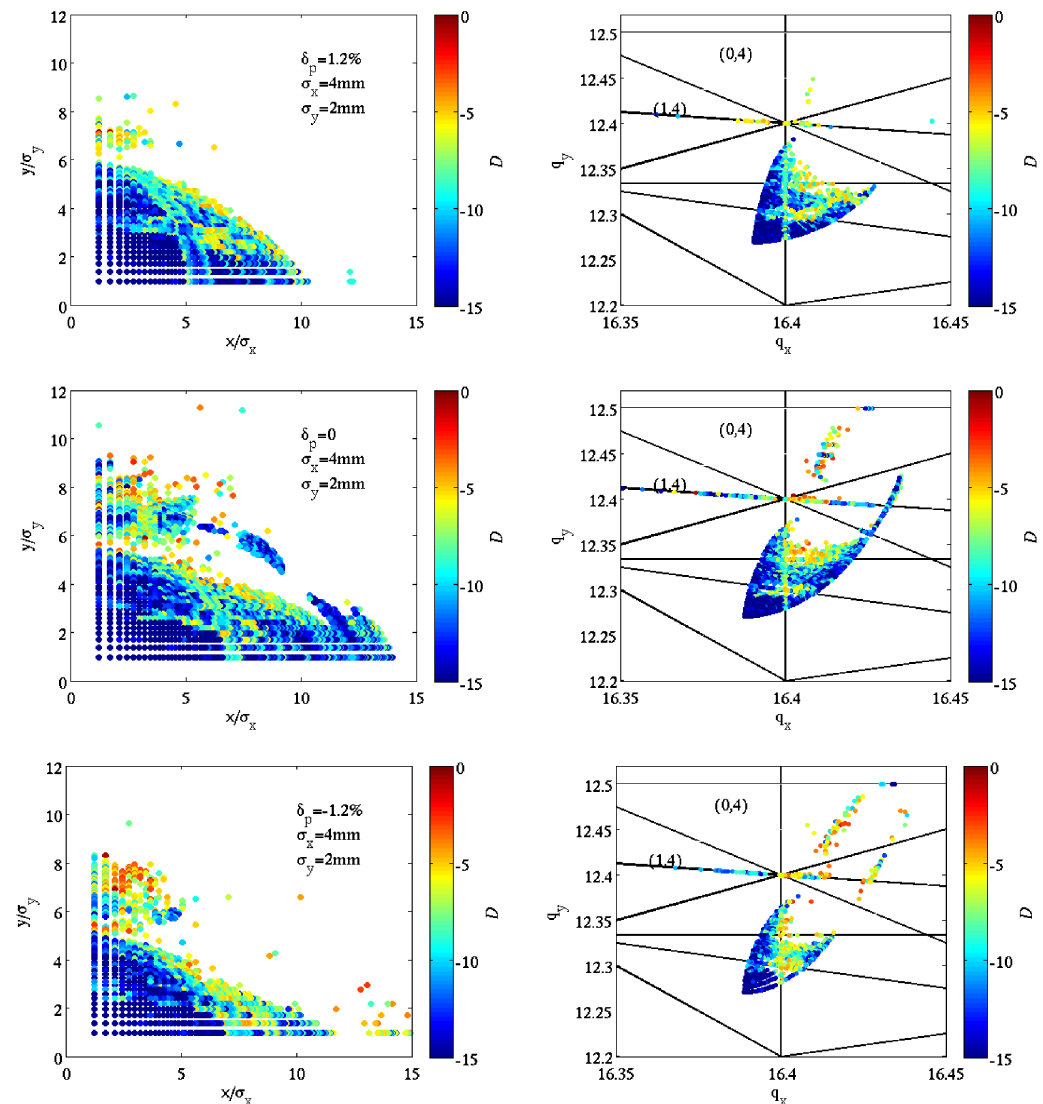
FIG. 17. Diffusion maps (left) and frequency maps (right) for δ p=p ¼ 1 . 2% (top), 0 (middle), and − 1 . 2